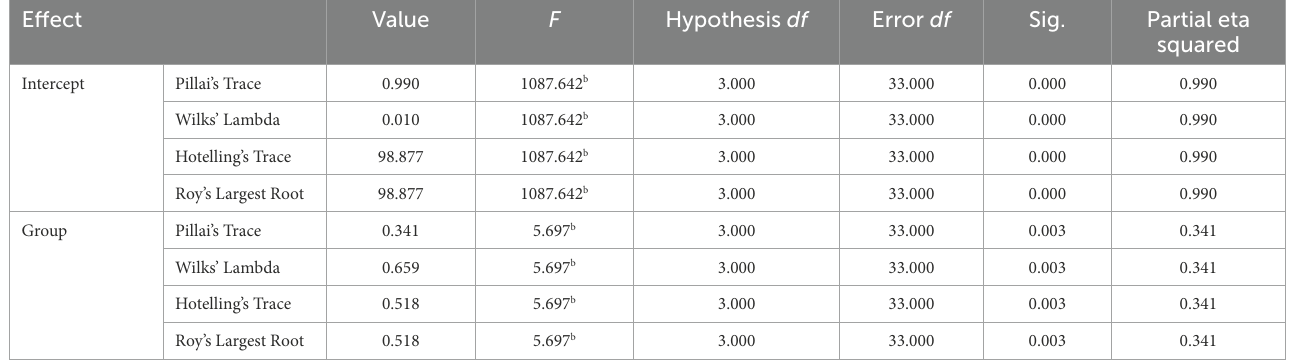
TABLE 3 Multivariate tests a for the scores obtained on post-tests.